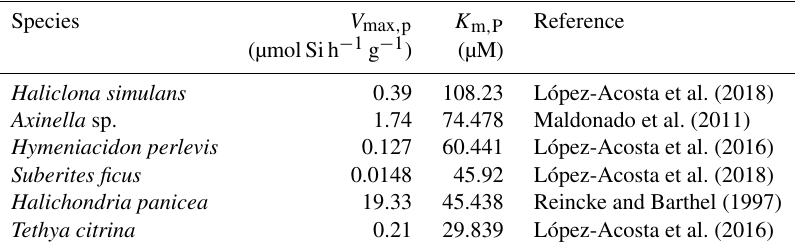
Table 2. Summary of Michaelis–Menten enzyme kinetic parameters of sponges used to model ε f (Fig. 6) following Eq. (2) with V max , p the the maximum polymerisation rates and K m , P the half saturation constant of